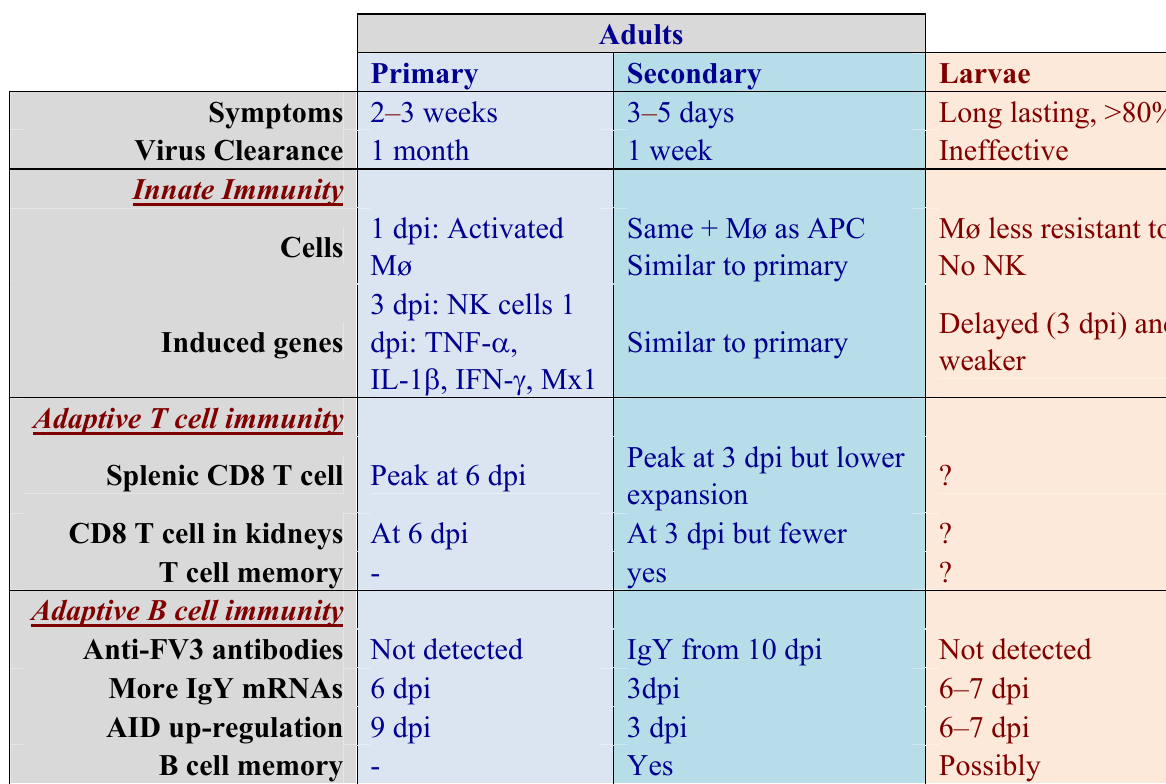
Table 1. Summary of immune responses to FV3 in larval and adult X. laevis